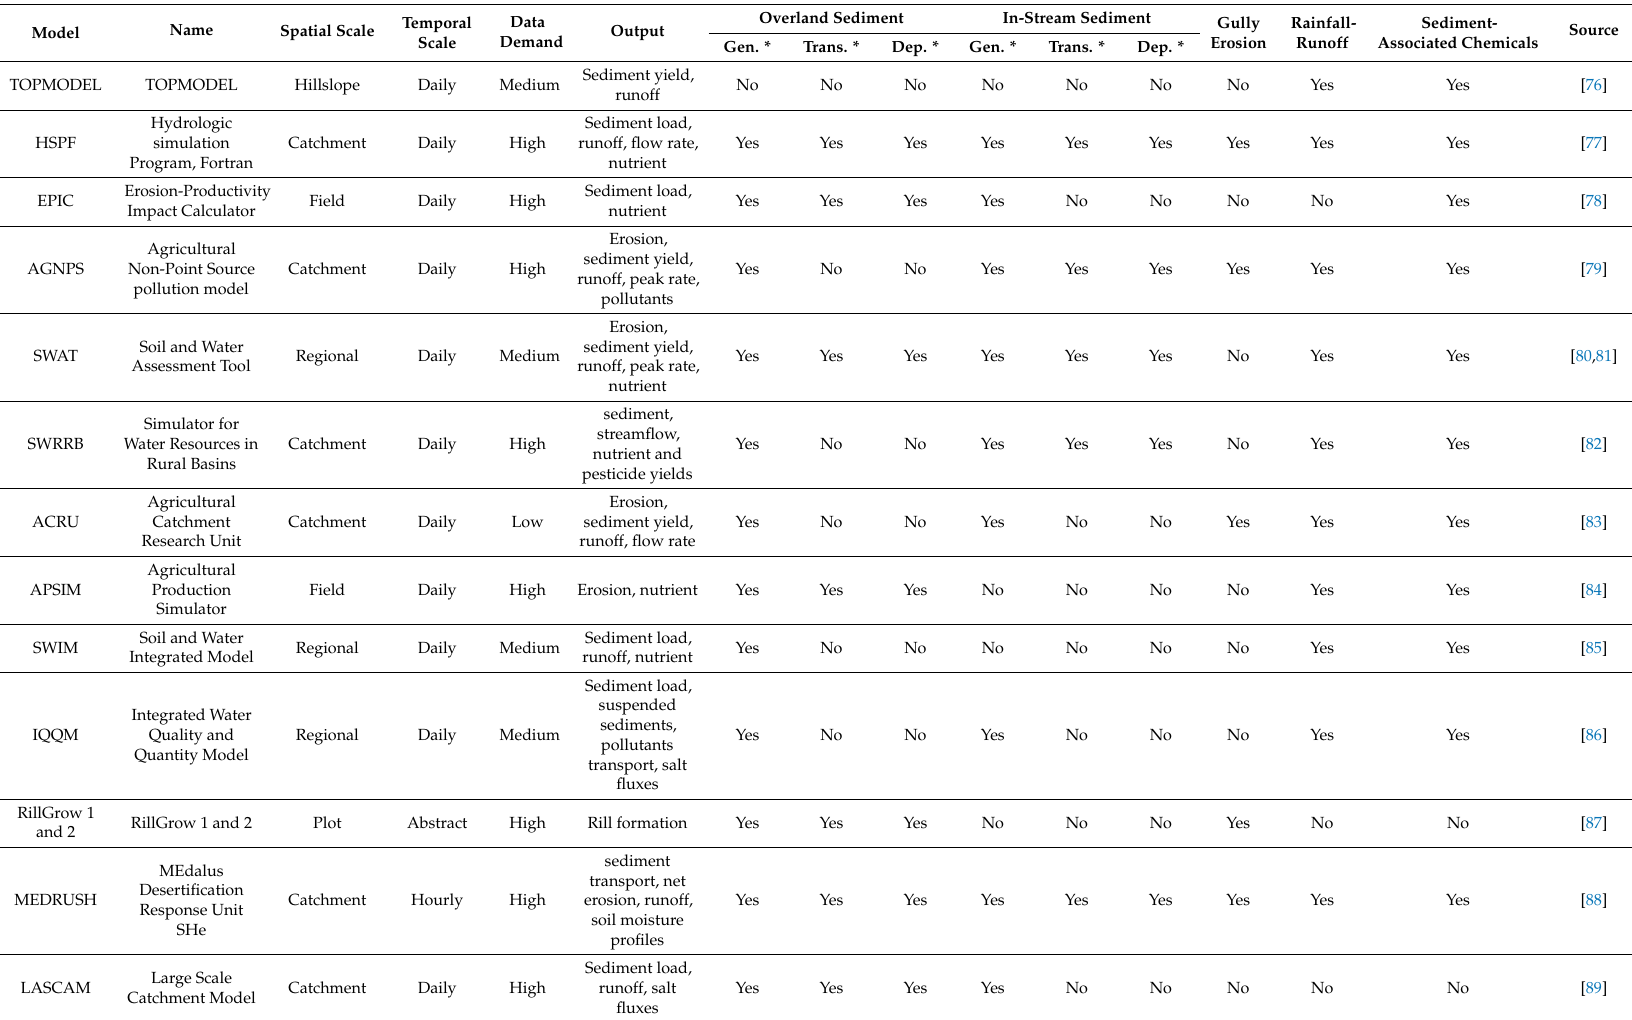
Table 2. Conceptual soil erosion